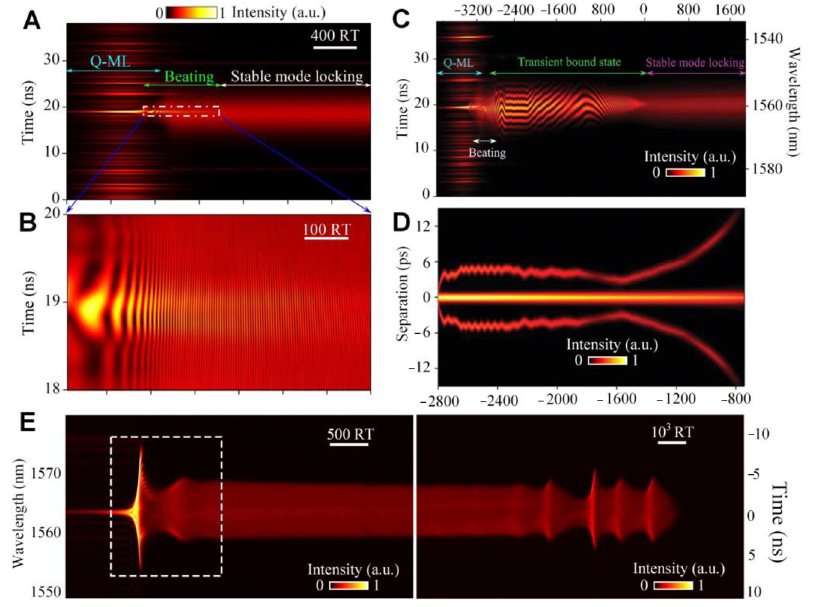
Figure 11: Entire buildup dynamics of conventional soliton and dissipative soliton. (A, B) Formation dynamics of single soliton with beating dynamics; (C, D) Buildup dynamics of single soliton with transient bound state. Liu et al. [216]. © SPIE 2019; (E) Formation and extinction dynamics of dissipative soliton. Cui et al. [227]. © Chinese Laser Press